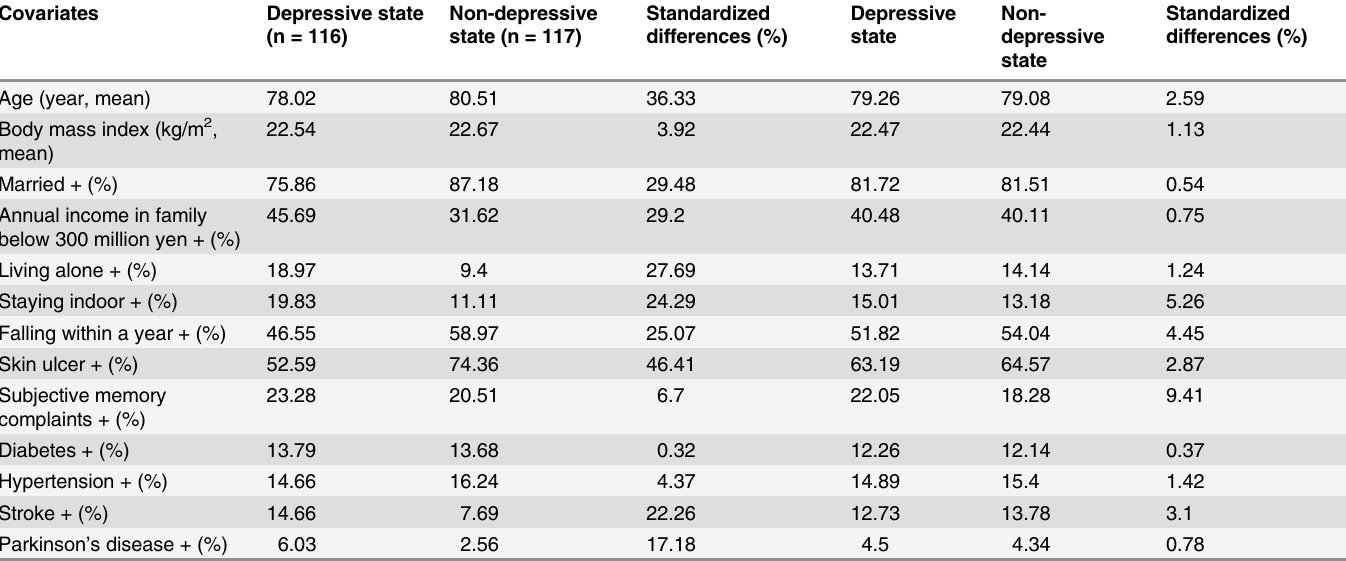
Table 2. Means, proportions, and absolute values of standardized differences before and after IPTW with propensity scores in men.